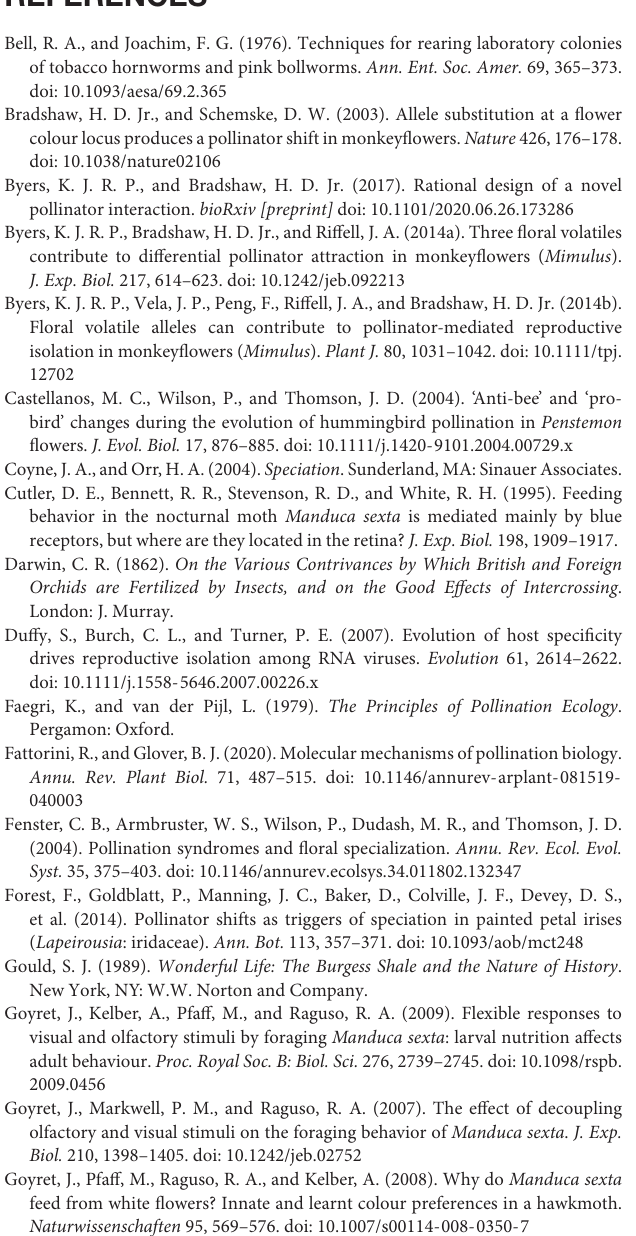
floral color for each moth (from bottom to top of each bar: white, pink, yellow, red). (B) Total visit time broken down by floral color for each moth [as in (A) ]. Supplementary Figure 3 | Moth transitions to flowers of each color based on distance flown to that flower. “Transition index” is the ratio of the percentage of time moths flew to a given color to the percentage of time that color was n positions away from the origin color, where a higher transition index indicates a larger percentage of the time that a given color was flown to. Supplementary Table 1 | Experimental design and raw data from hawkmoth visitation